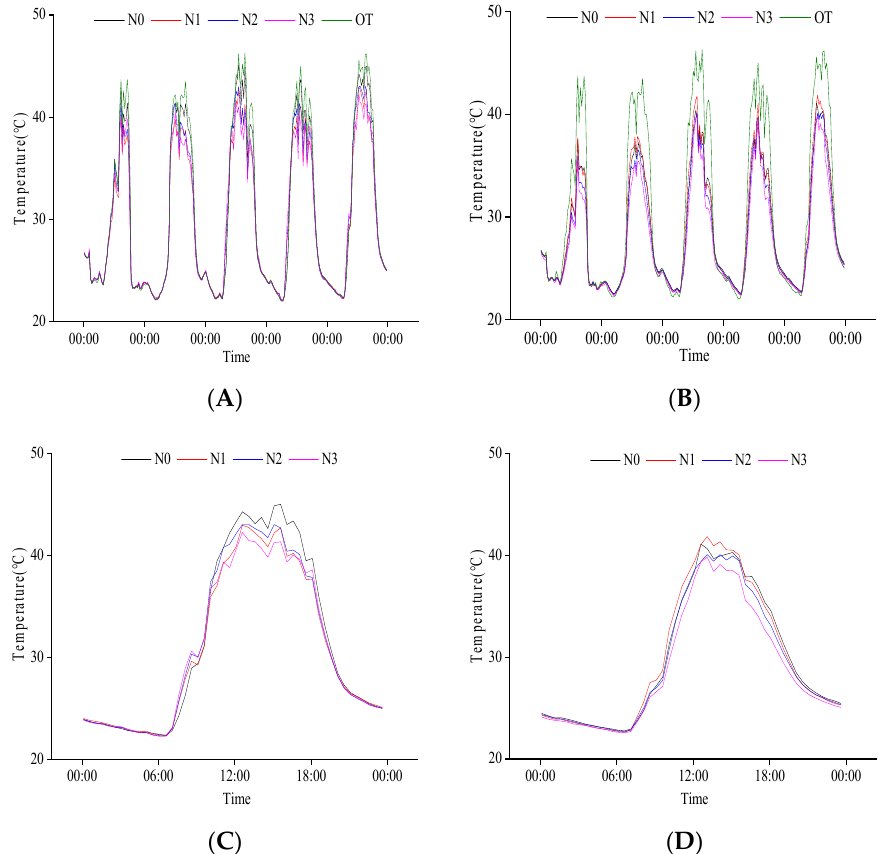
Figure 4. Daily variation in temperature at grain filling stage. ( A ) Canopy population temperature from 16 August to 20 August; ( B ) Baselayer temperature of the population from 16 August to 20 August; ( C ) Canopy temperature of the population on 20 August; ( D ) Baselayer temperature of the population on 20 August. OT is the change in external temperature, N0, N1, N2, and N3 are the effects of different nitrogen fertilizers on population temperature under P1 conditions.